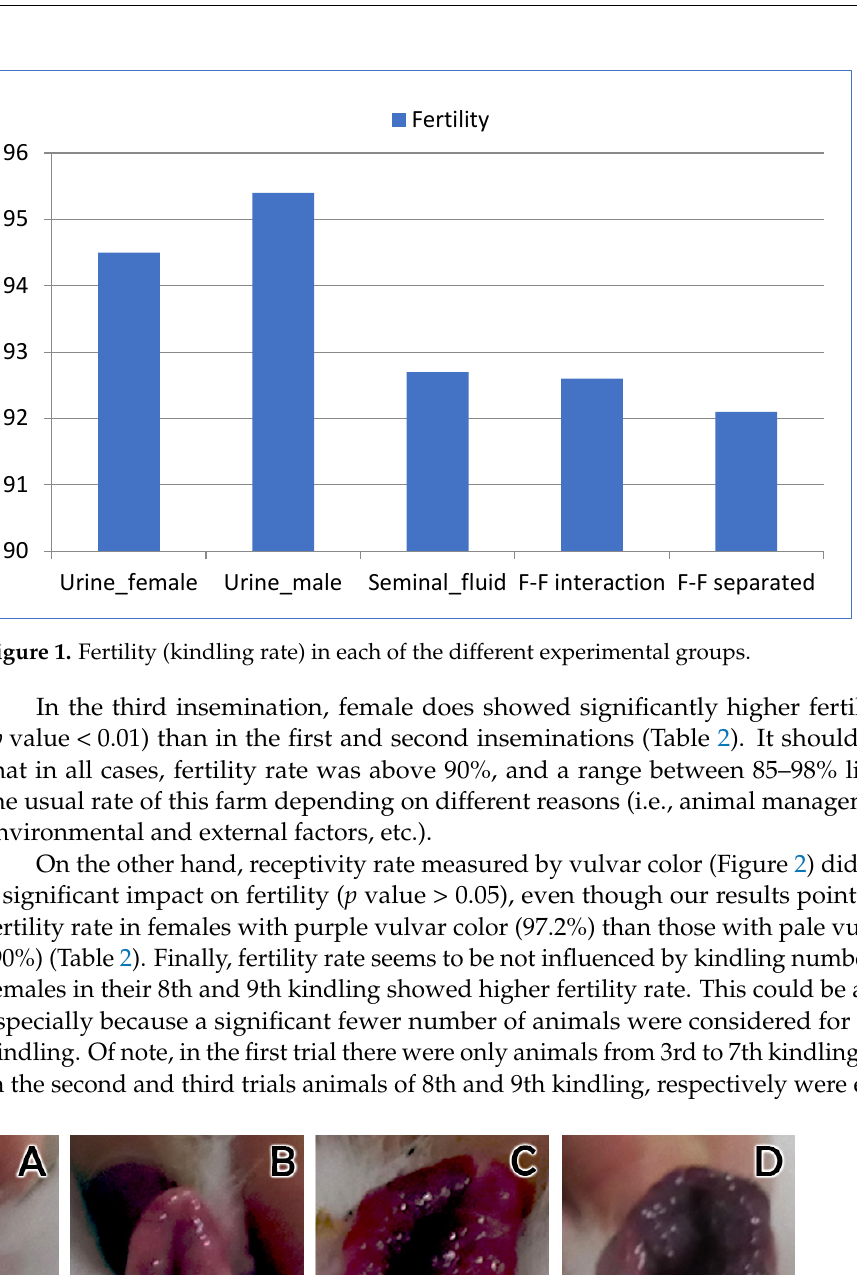
Figure 3. Prolificacy rate (number of born alive / dead animals) in each of the different experi- mental groups. Moreover, we did find significant differences in the prolificacy rate depending on the receptivity (Figure 4). Four vulvar colors have been previously described to assess receptivity rate: pale, pink, red and purple (Figure 1), showing increasing levels of re- ceptivity [25]. We saw that females showing pale vulvar color at the time of AI had a significant reduced number of total born kits when compared to females with pink and red vulvar colors ( p value < 0.01). Our data confirmed that prolificacy depends on sexual 02 46810 1214 1618 total born alive dead